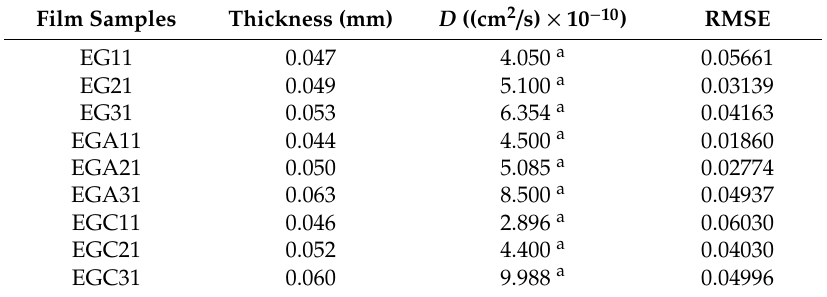
Table 5. Di ff usion coe ffi cients of one-way release of CEOs released from films to water at 4 ◦ C.